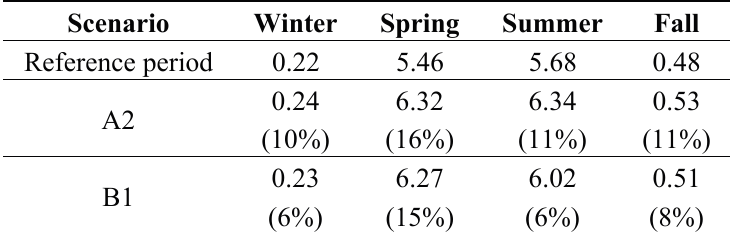
Table 4. Mean seasonal stream flow during the reference period (2000–2011) and A2 and B1 scenarios during the long-term period (2020–2040). The values within the parentheses are relative changes. The unit of stream flow is m 3